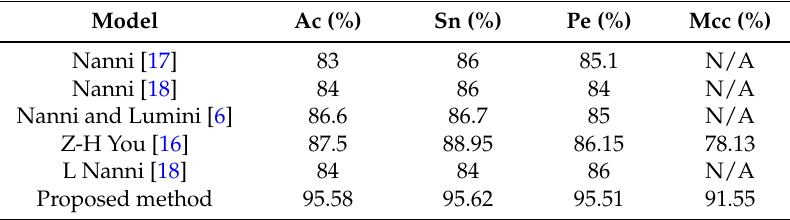
Table 6. Predicting ability of different methods on the H. pylori